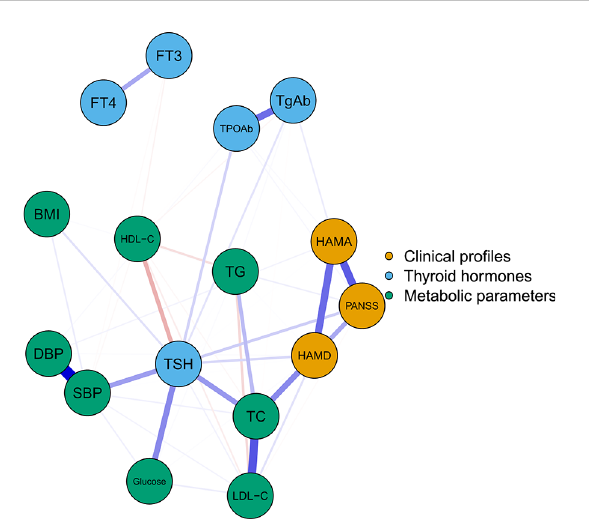
FIGURE 1 The undirected network of thyroid hormones, metabolic parameters, and clinical symptoms The blue, green, and orange nodes represent thyroid hormones, metabolic parameters, and clinical pro fi les, respectively. Blue edges indicate positive association while red edges indicate negative association. Thicker edge implies a stronger association. HAMD, Hamilton Depression Rating Scale; HAMA, Hamilton Anxiety Rating Scale; PANSS, the Positive and Negative Syndrome Scale; TSH, thyroid-stimulating hormone; FT3, free triiodothyronine; FT4, free thyroxine; TgAb, antithyroglobulin; TPOAb, thyroid peroxidases antibody; TC, total cholesterol; HDL-C, high-density lipoprotein; LDL-C, low-density lipoprotein; TG, total triglycerides; BMI, body mass